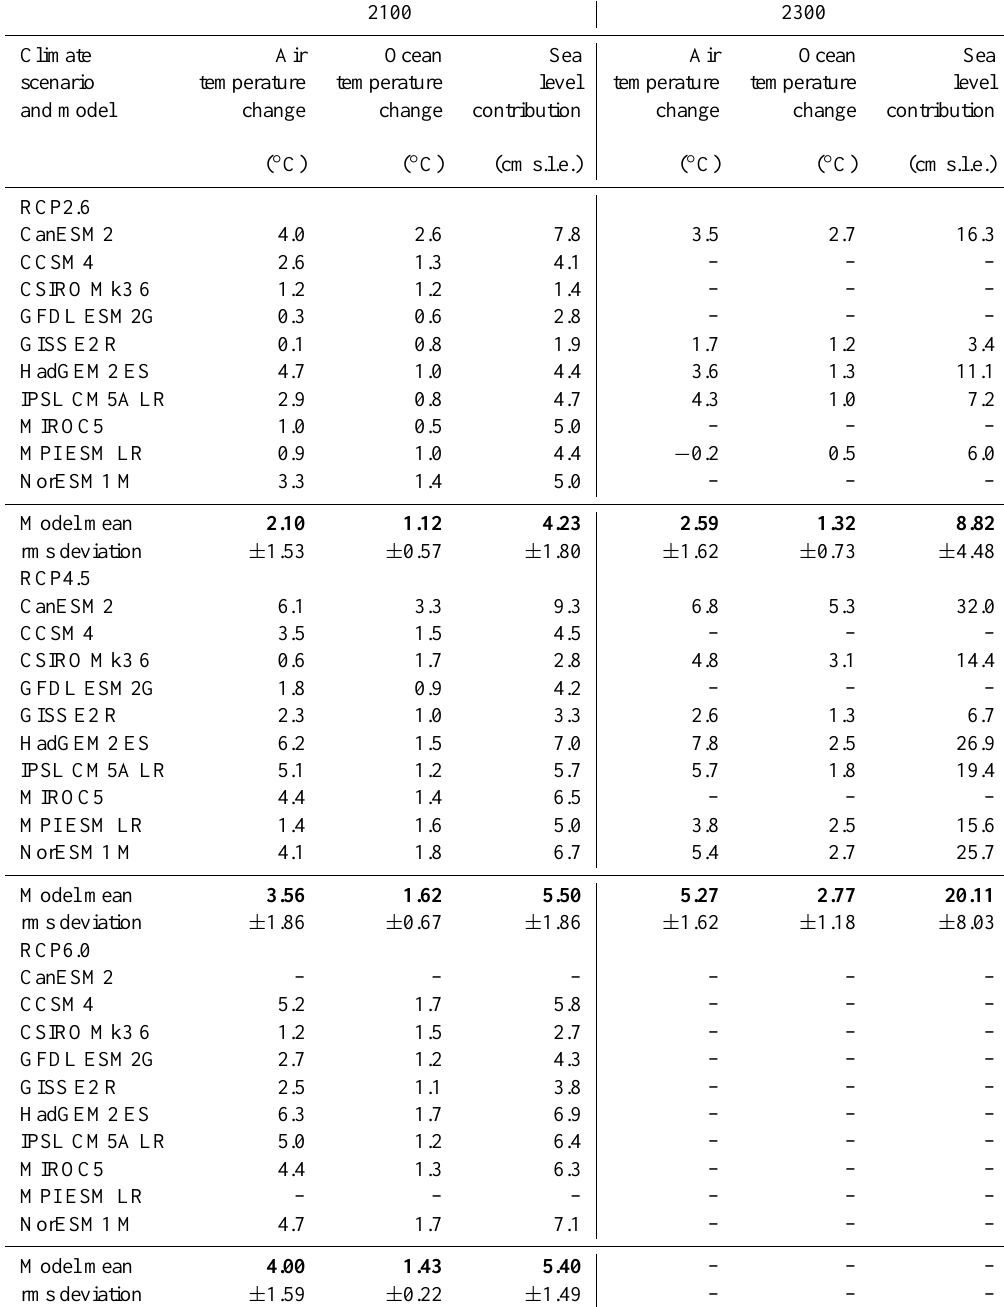
Table B1. Atmospheric and oceanic temperature forcing as provided by the AOGCMs given together with the resulting Greenland ice sheet contribution to sea-level change by 2100 and 2300. Sea-level contribution is determined with respect to 2000. Ocean temperatures are basin averages. Also provided are model means and root mean square deviations (RMSDs) from the mean for each RCP scenario. En dashes indicate no data for the selected model and period. Ensemble averages are given in